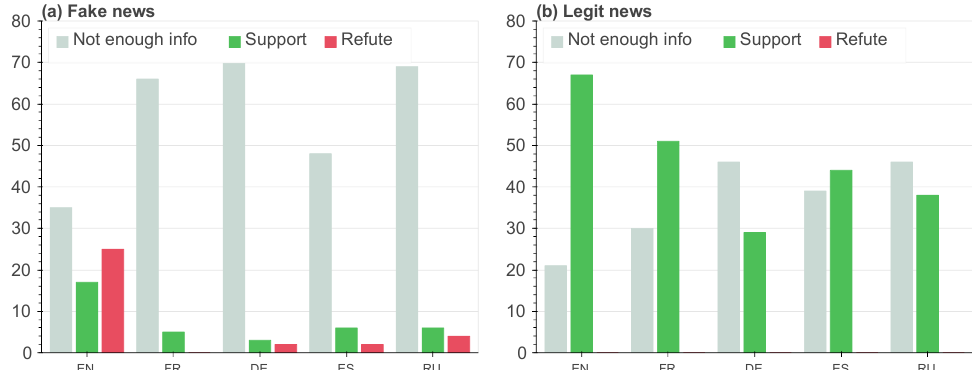
Figure 4. The results of the manual annotation: the distribution of answers for fake ( a ) and legit ( b ) news. As we can see, the amount of support news from the search results for every language for legit news incredibly overcomes the amount for fake news. At the same time, there is almost no ’refute’ news for legit news, while ’refute’ news appeared in the search results for fake news across all